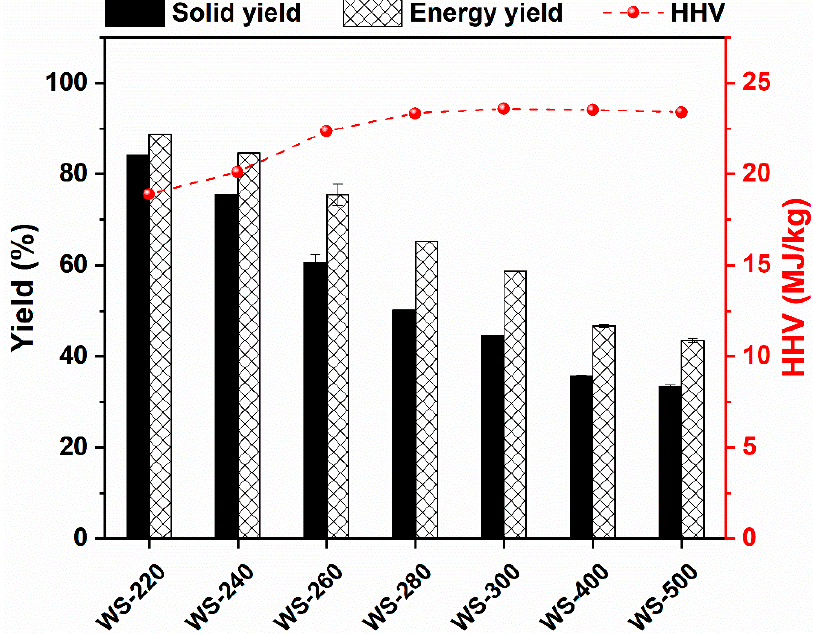
Figure 3. Mass yield, energy yield, and energy density of WS treated at various temperatures.